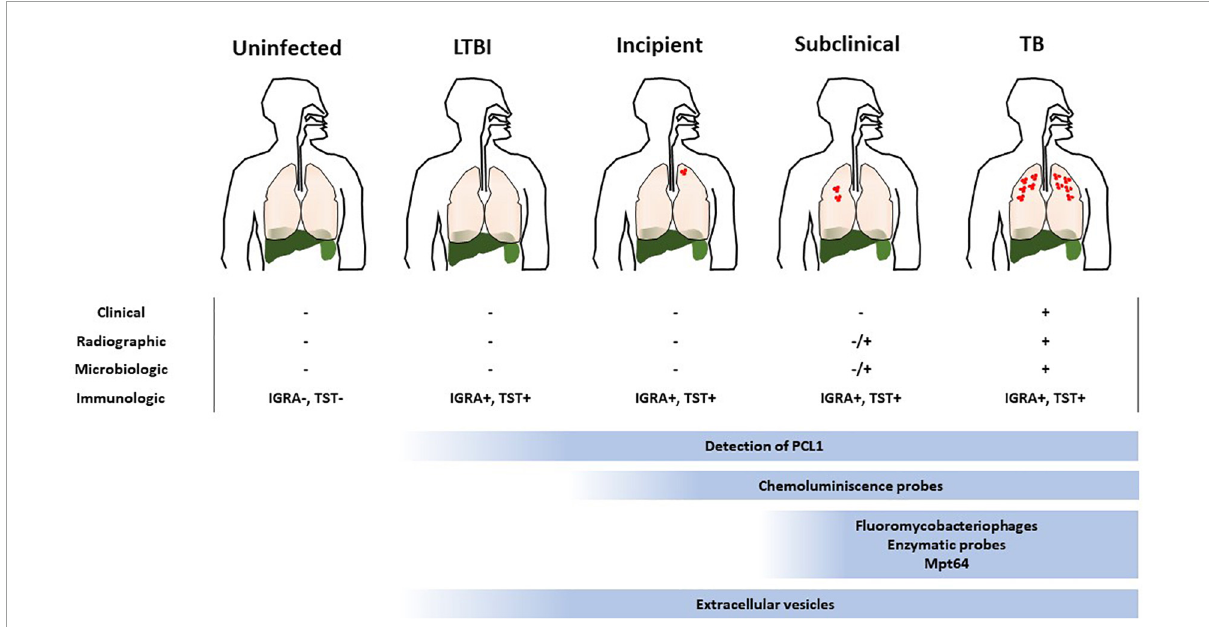
FIGURE2 Suitability of the different approaches to detect viable Mtb within the TB disease spectrum. TB is represented as a spectrum of different states where current immunologic approaches to diagnose it are confounding. Determination of the viability of the infecting bacillus is key to ascertain the risk of developing TB, specially at early stages of the disease (LTBI, incipient and subclinical TB). The low bacterial burden associated to such states makes it difficult to implement methods to accomplish this. The suitability of the current methods to detect viable Mtb are depicted and the range where they could be useful is